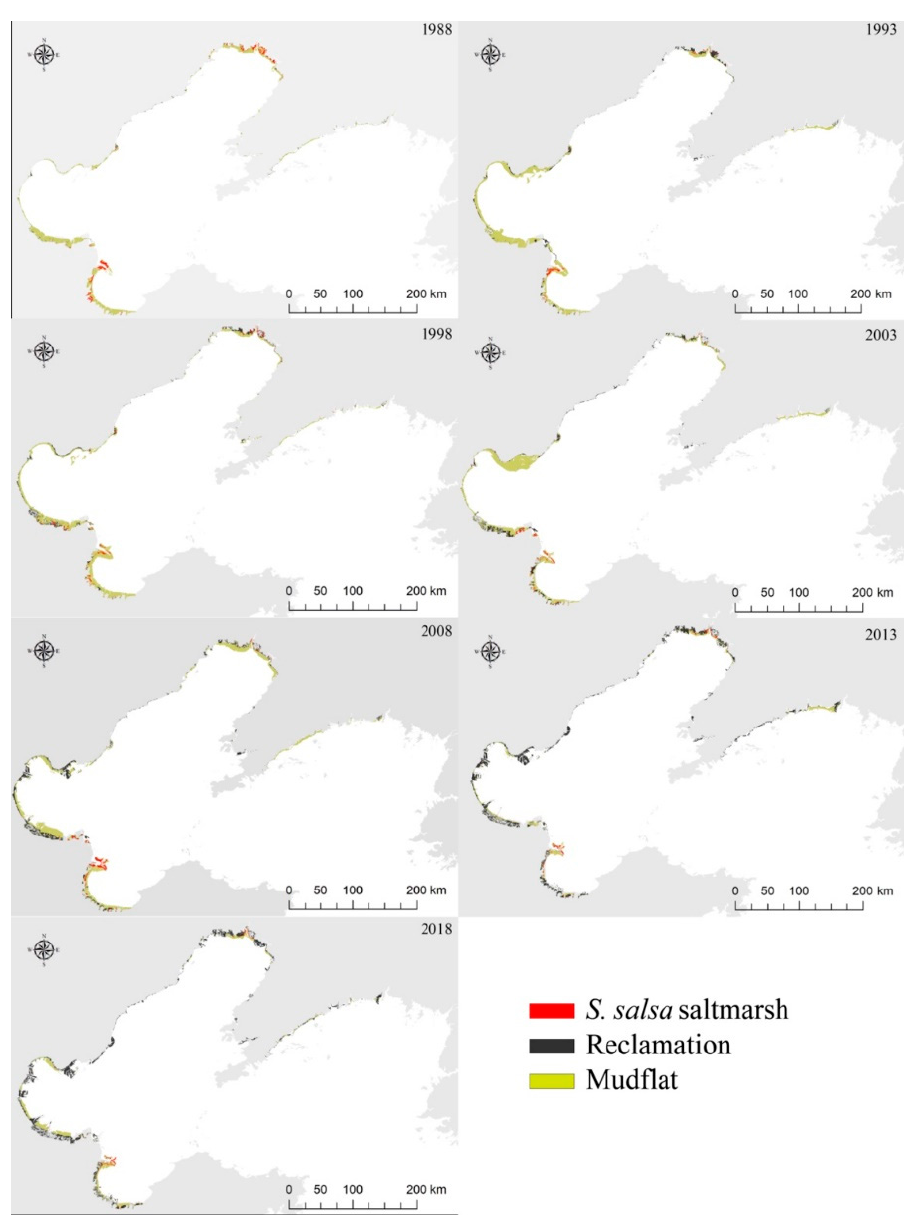
Figure 3. Total S. salsa saltmarsh area at different stages between 1988 and 2018 along the NYSC.